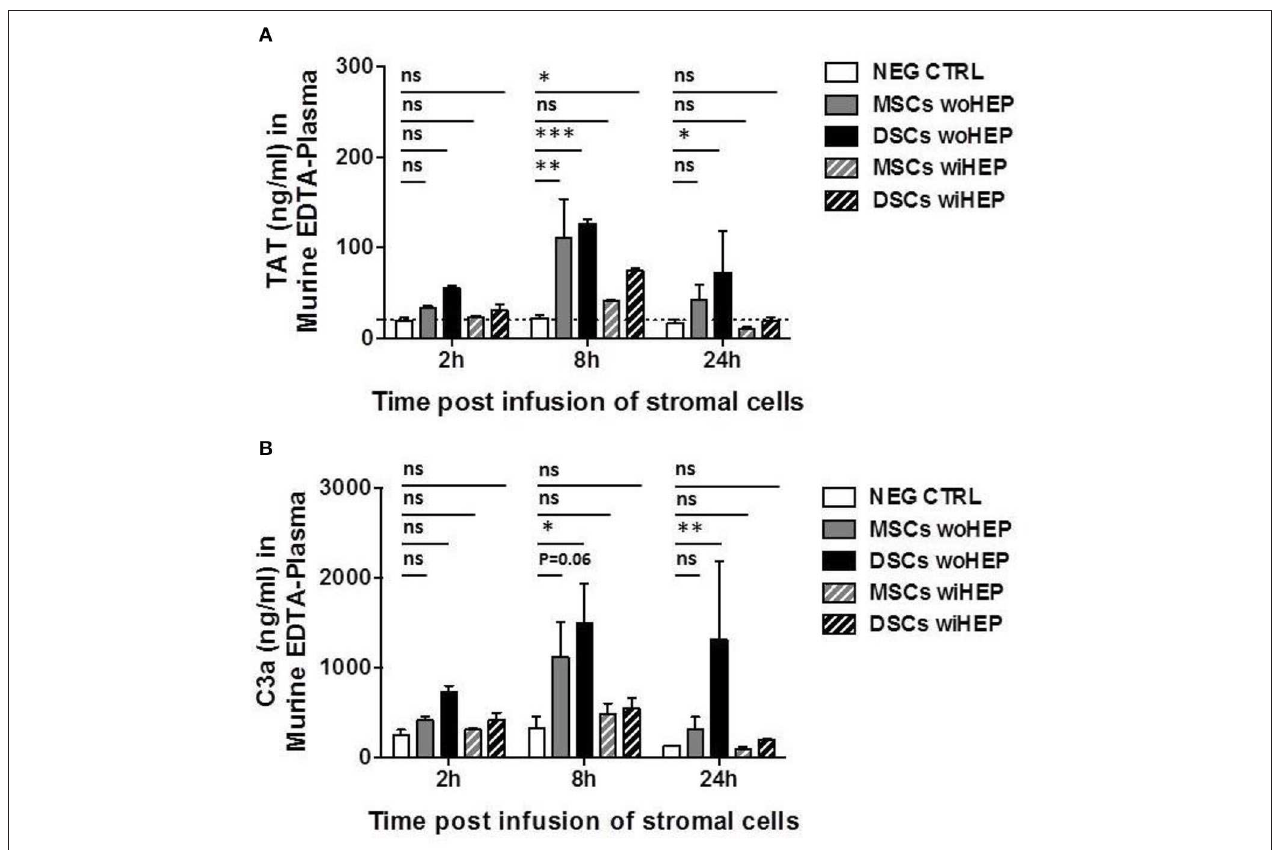
FIGURE 8 | Analysis of systemic coagulation and complement activation markers in mice after systemic infusion of stromal cells prepared with and without heparin. Aliquots of cryobanked therapeutic bone marrow mesenchymal stromal cells (MSCs) and placenta-derived decidua stromal cells (DSCs) were thawed, washed and reconstituted in buffer supplemented with or without low-dose heparin (HEP, final dose 10 units/animal), and infused at 500,000 cells/animal ( n = 2 animals each bar), and kinetics of coagulation and complement activation markers monitored after 2, 8, and 24h. Quantification of: (A) Coagulation activation marker TAT (ng/mL) and (B) Complement activation marker C3a (ng/mL) in murine EDTA-plasma. Mean ± SD. * P < 0.05, ** P < 0.01, and *** P < 0.001, and ns, not significant. Dashed lines indicate background levels of C3a and TAT. TAT, thrombin-anti-thrombin complex, and C3a, complement component 3 activation fragment